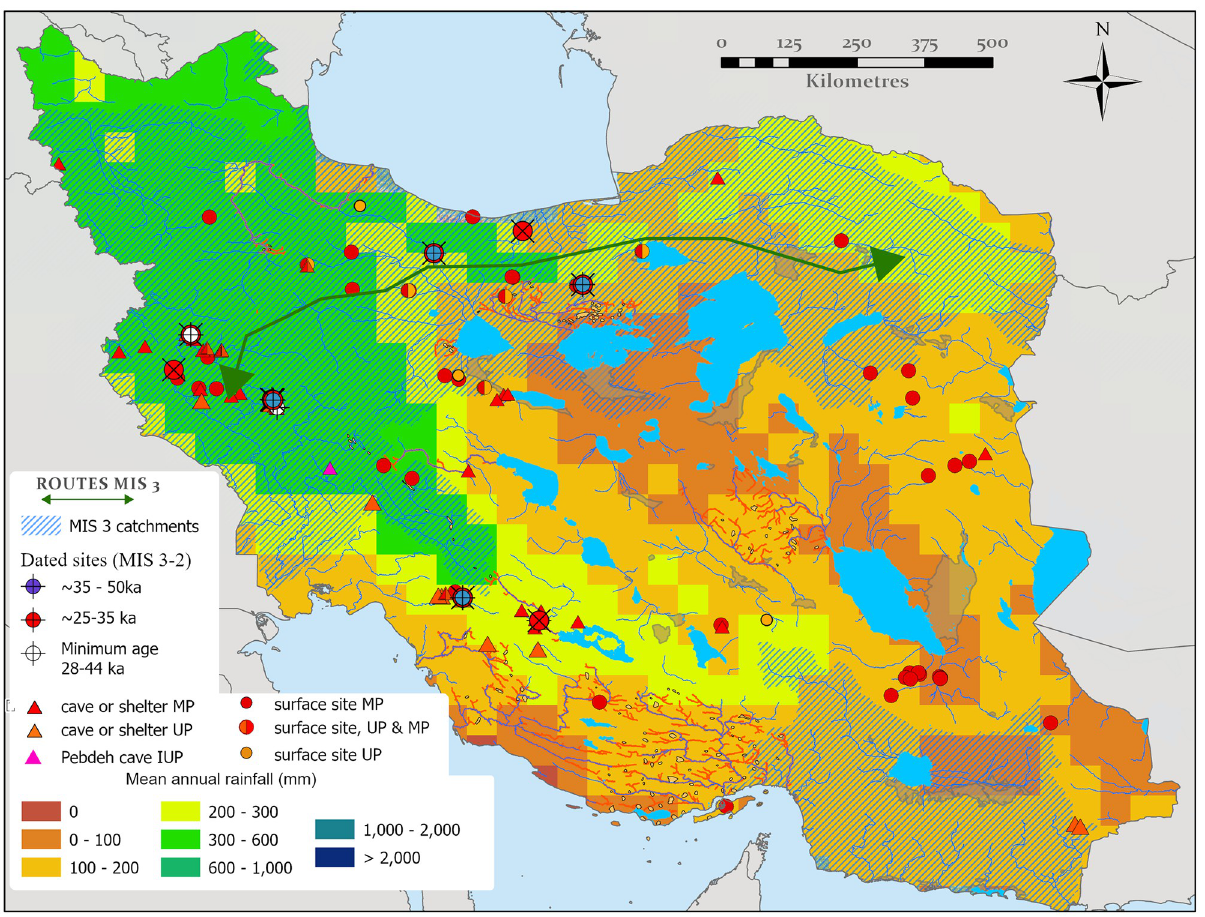
Fig 10. The distribution of MP and UP sites in relation to MIS 3 data. The base map is the Krapp et al. (50–40 ka) mean precipitation climate model [61], and is overlain by catchments where MIS 3 humidity and active hydrology (hatched) are suggested by our data (see Fig 6). Map created by one of our authors